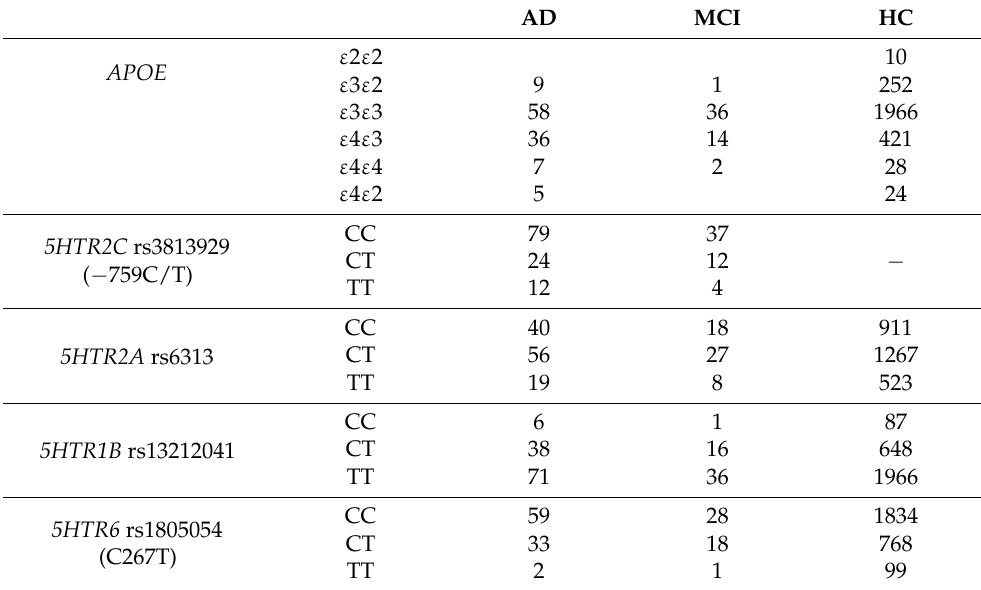
Table 2. Number of APOE and 5HTR genotypes in different